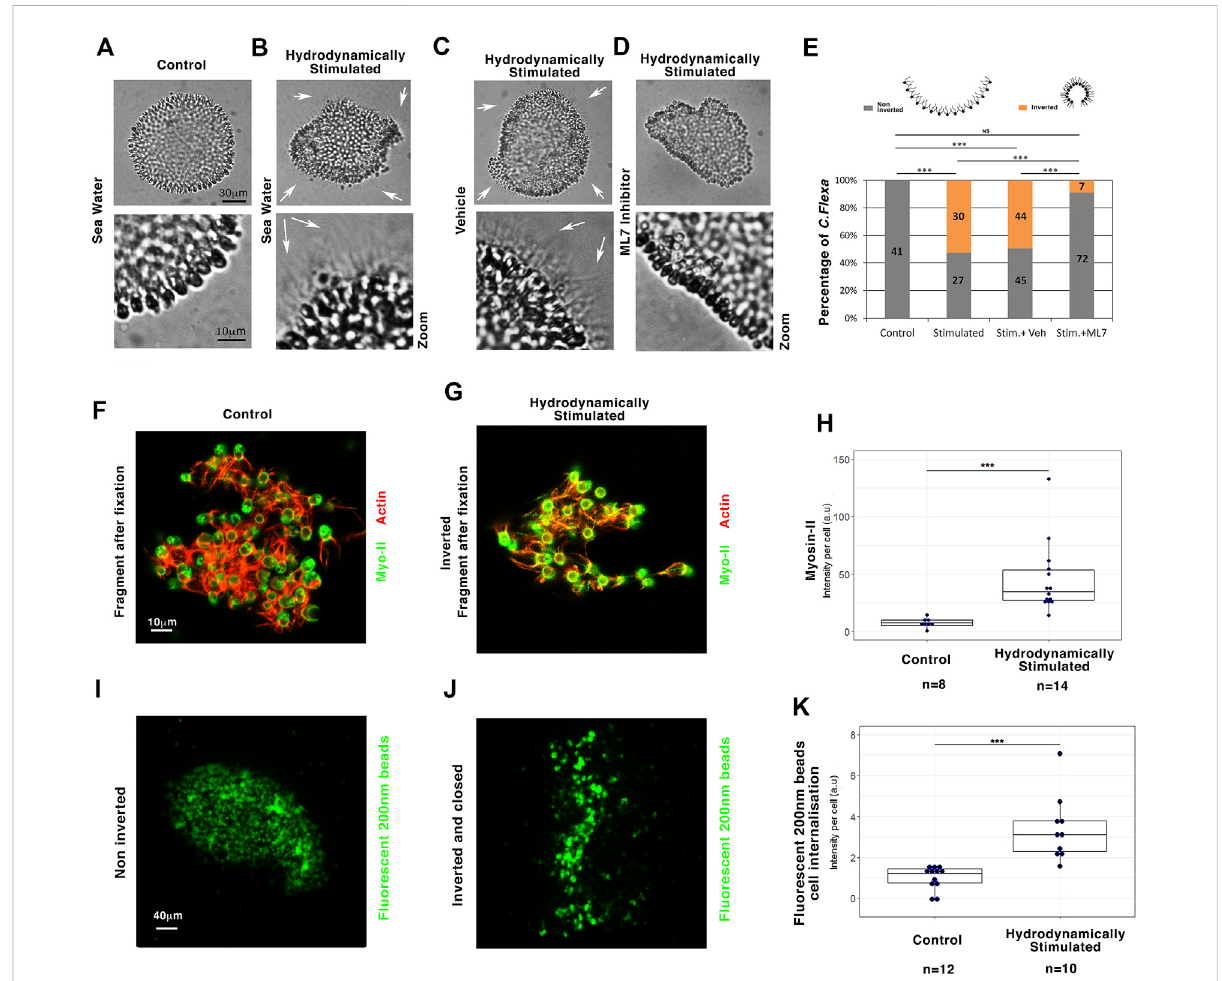
FIGURE 5 Myo-II-dependent hydrodynamic stimulation of multicellular sheet curvature inversion is conserved in C. fl exa choano fl agellates. (A) Multicellular C. fl exa choano fl agellatebefore hydrodynamicstimulation(no fl agellateoutside) (B) and afterhydrodynamic stimulation(whitearrows: fl agellateoutside). (C) Inversionstatus ofhydrodynamically stimulated C. fl exa treated withtheethanolvehicleofML7 alone (whitearrows: fl agellate outside) (D) and with the Myo-II inhibitor ML7 (no fl agellate outside). Zooms: with enhanced contrast to check for fl agellate presence. (E) Quantitative analysis. n Control = 41 and n Stimulated = 57, p = 10 – 9 , n Stim+veh = 99 and n Stim+ML7 = 79, p = 4.8.10 – 9 . Scheme from Brunet et al. (2019). (F) Myo-II and actin in C. fl exa before hydrodynamic stimulation (G) and after hydrodynamic stimulation. (H) Quantitative analyses of Myo-II expression percell20 – 30 minafterhydrodynamicstimulationinitiation.Immuno fl uorescencerepresentativeof n =8controlsand n =14invertedstructuresof thehydrodynamicallystimulated C. fl exa .n Control =8andn Stim =14, p =1.25.10 – 5 . (I) 200 nm fl uorescentbeadsinternalizationincellsinnon-inverted (J) and inverted C. fl exa after hydrodynamic stimulation. (K) Quantitative analyses of particle internalization per cell 60 min after hydrodynamic stimulation initiation. Immuno fl uorescence representative of n = 12 non-inverted and n = 10 fully inverted structures of the hydrodynamically stimulated C. fl exa . n Control = 12 and n Stim = 10, p = 9.9.10 – 5 . N = 2 biological replicates. Statistical tests are Fisher for histograms and Mann – Whitney for quantitative